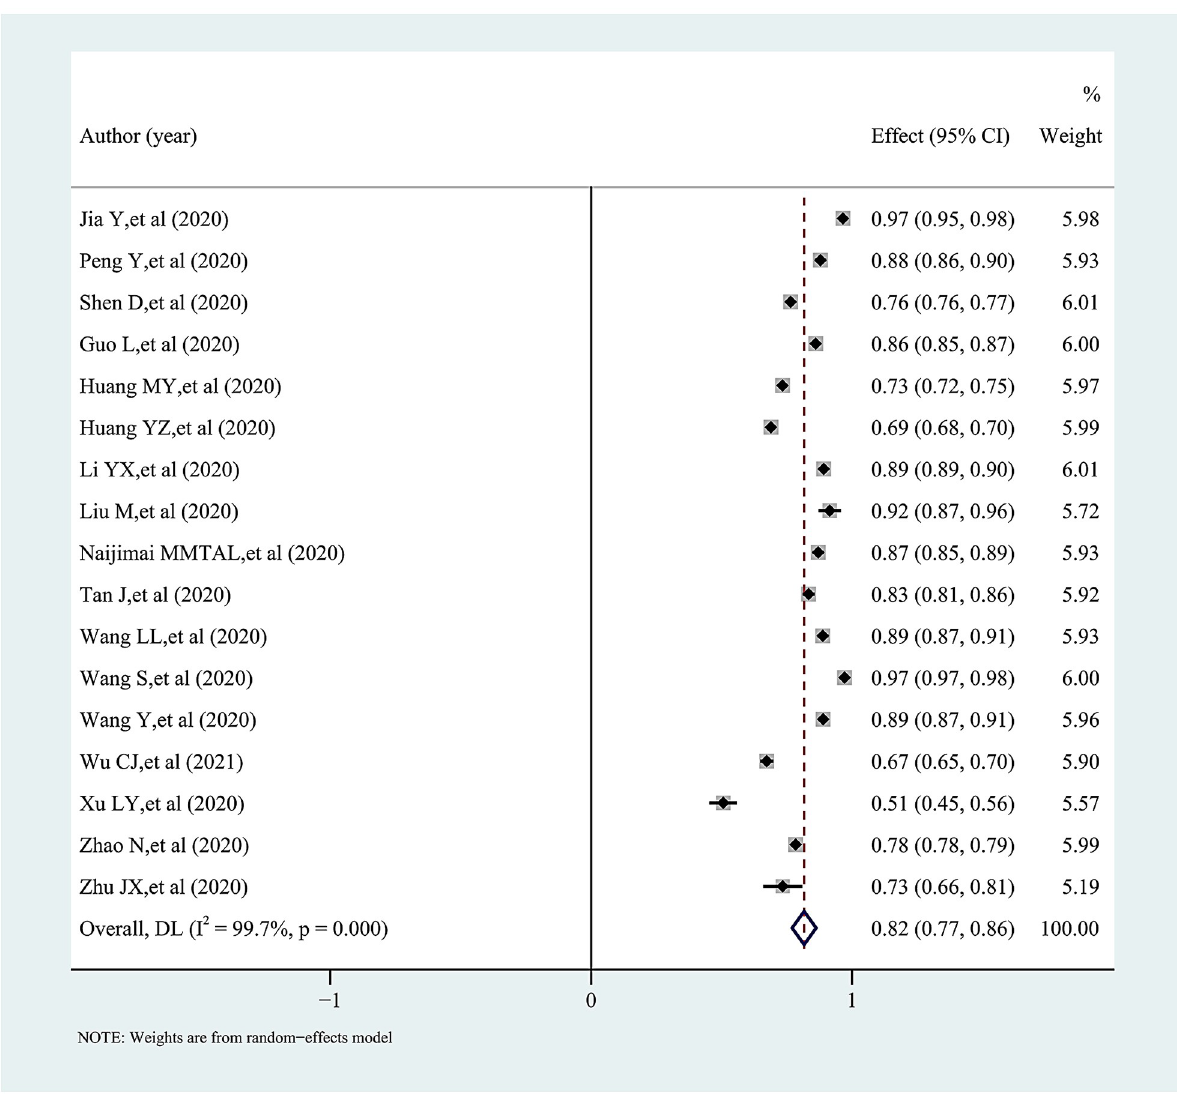
Fig 5. Forest plot showing the pooled proportion of using specific measures to fight COVID-19 among study subjects.